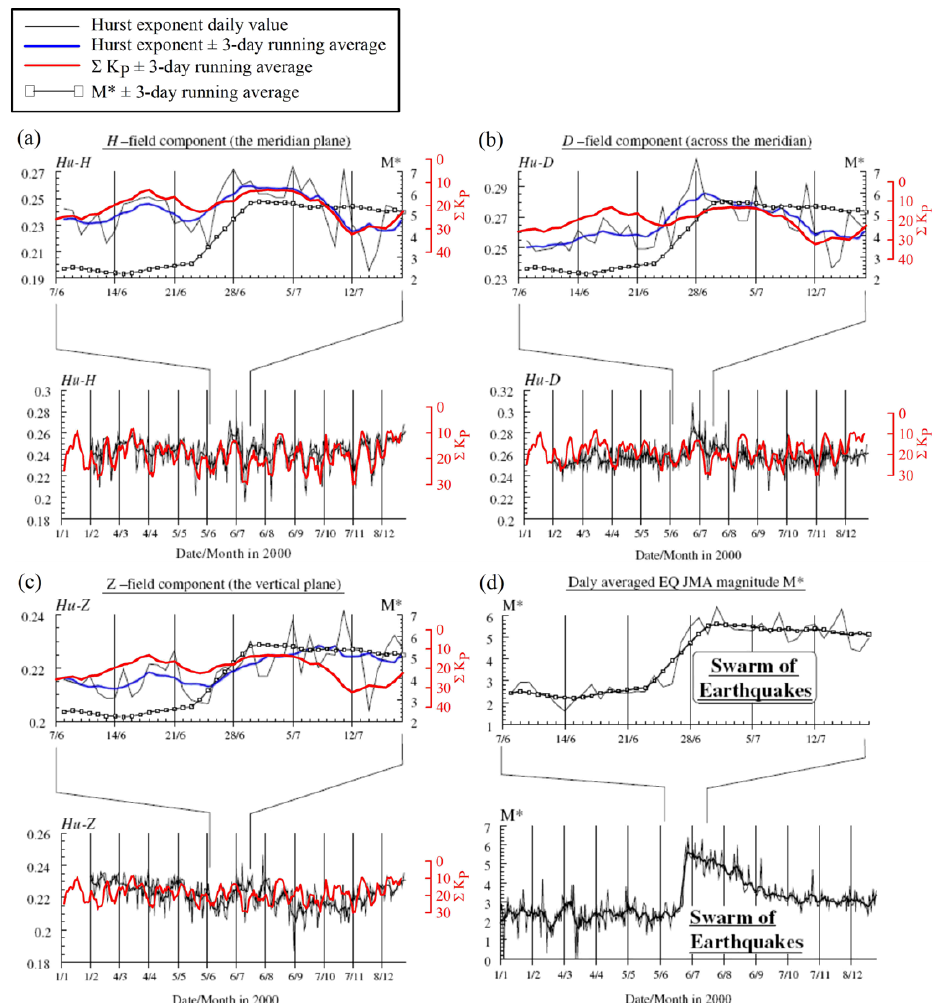
Fig. 2. A reproduction of Fig. 2 by Hayakawa et al. (2004). (a) , (b) , and (c) the variation of the Hurst exponent (daily values and ± 3-day running average) of the geomagnetic field components H , D , and Z during 2000. The enlarged views of each panel refer to the rise of the seismic activity at Izu. (d) daily values and ± 3-day running average of the earthquake magnitude M ∗ . The ± 3-day running average of M ∗ (solid line with open squares) is also reported in panels (a) , (b) , and (c) . The ± 3-day running average of the global geomagnetic index 6 Kp is superimposed on the original views. See text for